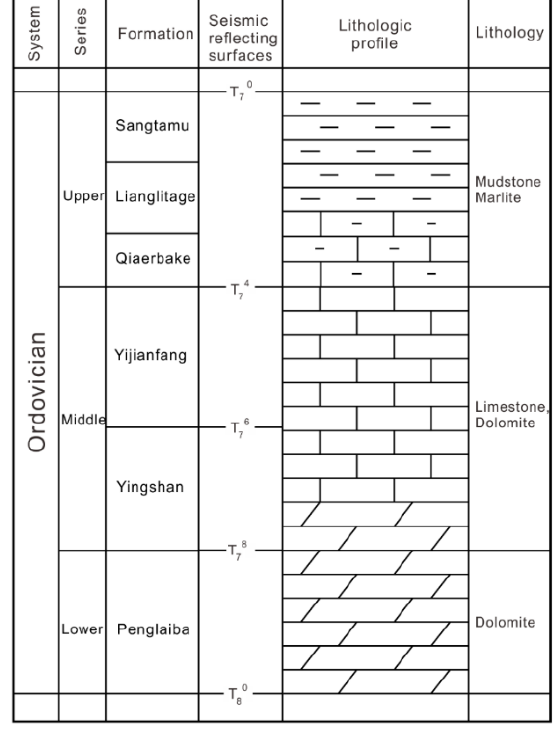
Figure 3. Stratigraphy and lithology in the study area.